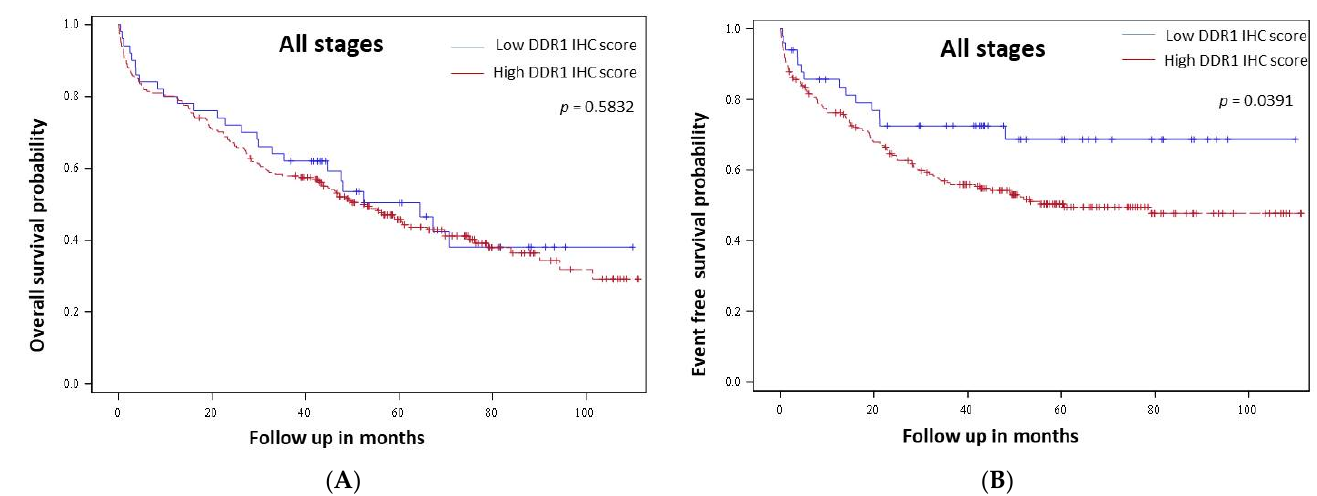
Figure 2. DDR1 value as a prognosis indicator in colon cancer patients from our cohort. Kaplan-Meier curves of overall survival ( A ) and event free-survival ( B ) probability for low (blue line) and high (red line) DDR1 immunohistochemical expression in adenocarcinoma cells from all tumor stages.